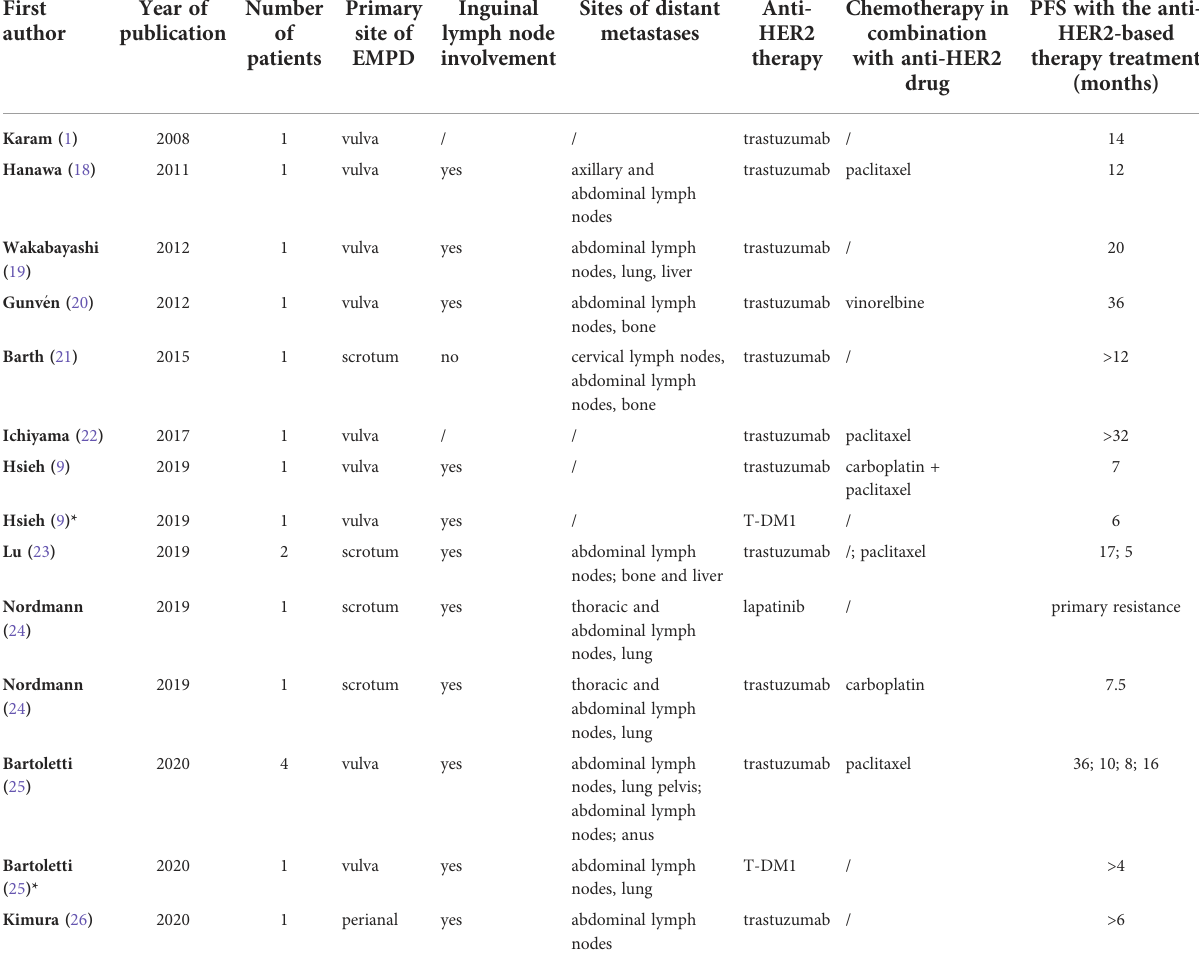
TABLE 1 Available case series of locally advanced or metastatic HER2-positive EMPD treated with anti-HER2 therapies alone or in